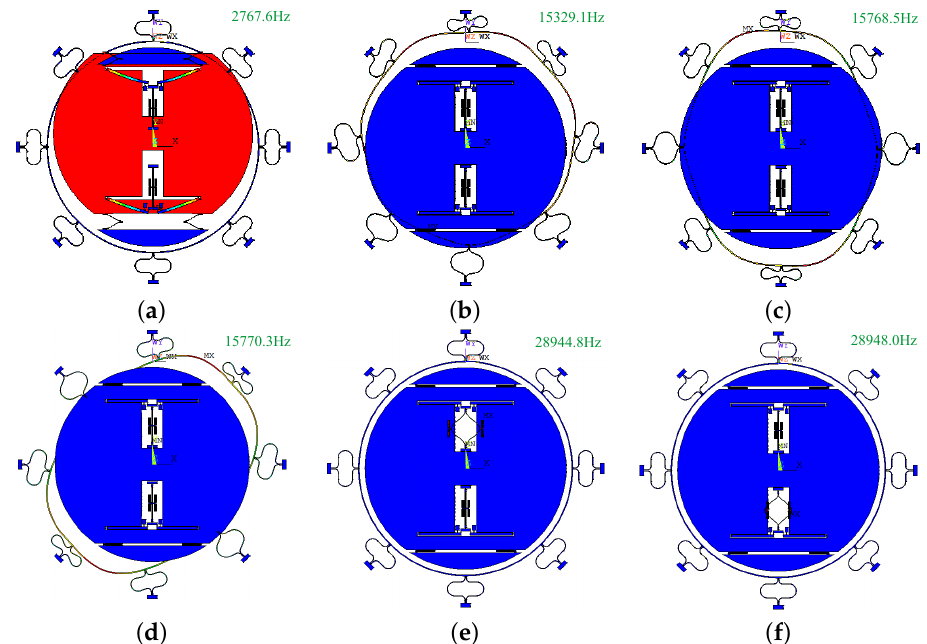
Figure 7. Modal analysis of the single-chip integrated accelerometer gyroscope. ( a ) The translational mode of the RA. ( b ) The translational mode of the RG. ( c ) The x-mode n = 2. ( d ) the y-mode n = 2. ( e ) The mode of upper DETF. ( f ) The mode of lower